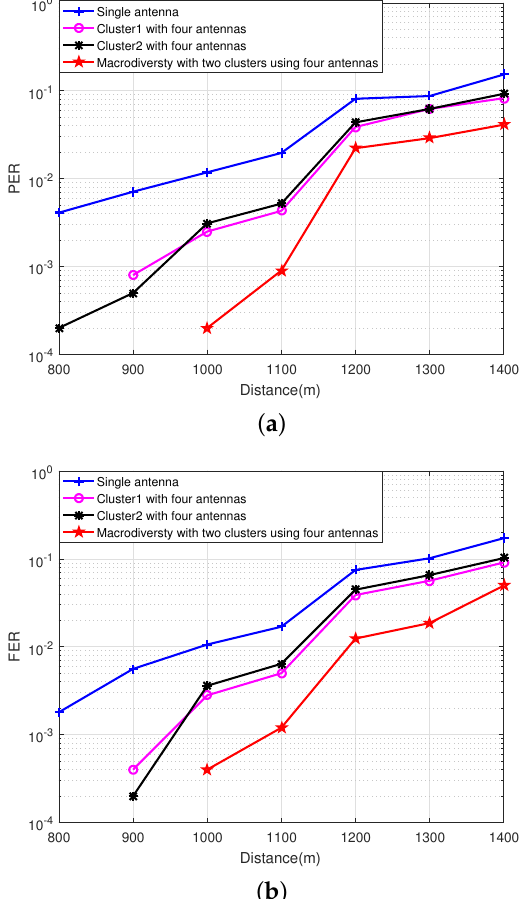
Figure 9. The relationship between performance of macrodiversity reception scheme using different number of antennas and transmission distance. ( a ) The relationship between PER of macrodiversity reception scheme using different number of antennas and transmission distance. ( b ) The relationship between FER of macrodiversity reception scheme using different number of antennas and transmission